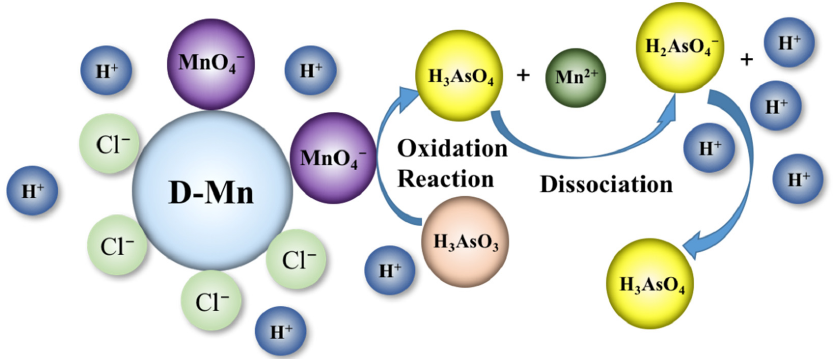
Scheme 1. Schematic representation of the effect of high Cl − ion concentration on the As adsorption of the D-Mn gel.